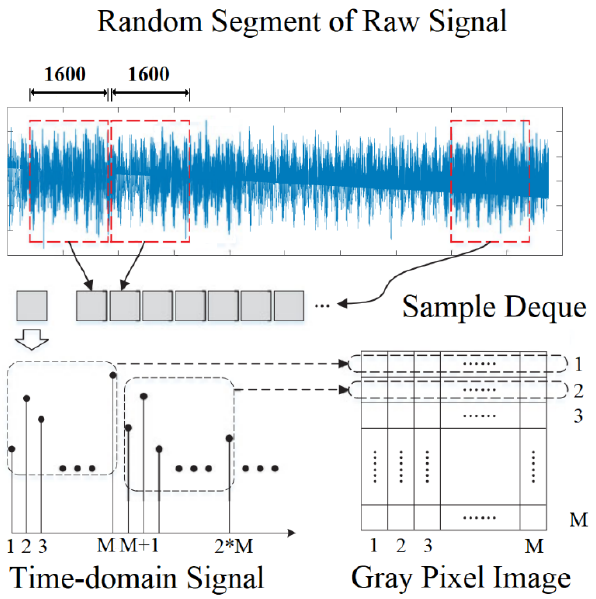
Figure 3. Two-Dimensional Time Domain Matrix.